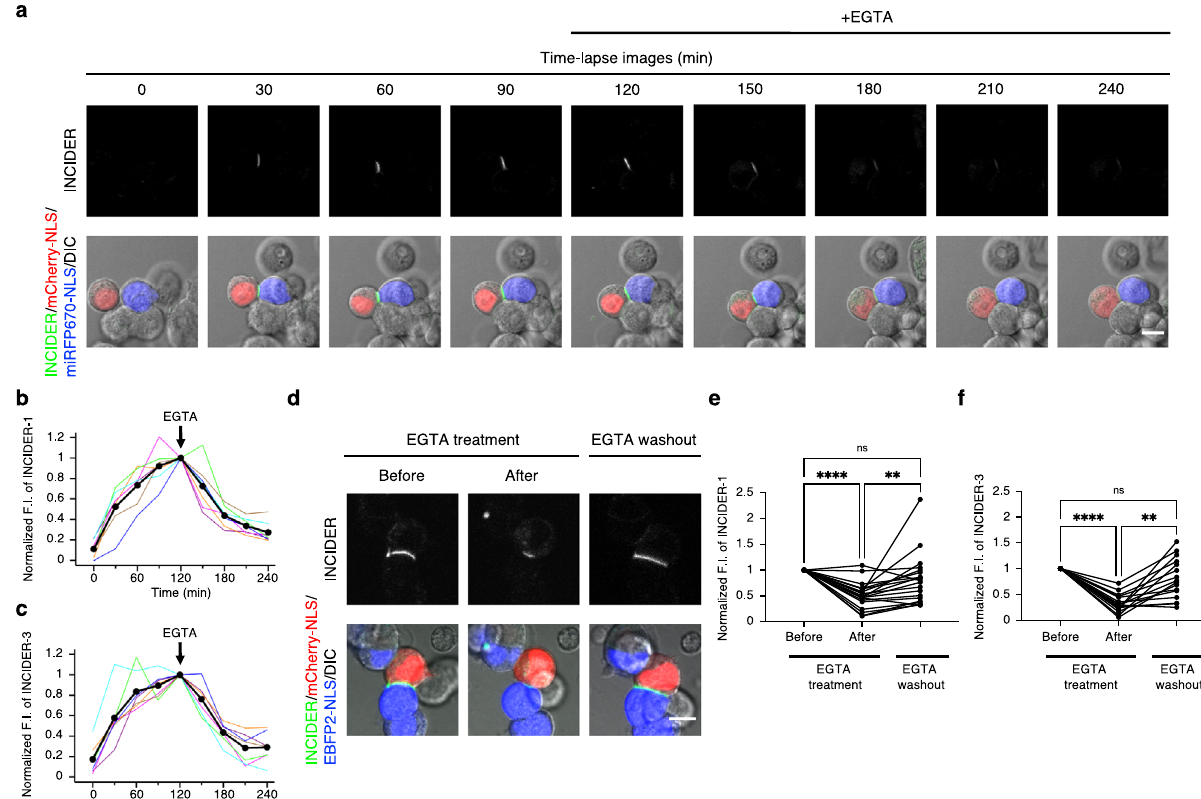
Fig. 4 Monitoring of the dynamics of NCad interactions. a Time-lapse images of INCIDER-1. HEK293T cells individually expressing INCIDER-1 components (NCad-GA and NCad-B1) were observed for 120 min immediately after seeding. 10 mM EGTA was administrated 120 min after seeding, and cells were imaged for a further 120 min. NCad-GA and NCad-B1 expressing cells were marked by mCherry-NLS and miRFP670-NLS, respectively. Scale bar, 10 μ m. b , c The normalized fl uorescence intensities at the cell adhesion sites formed by INCIDER-1 ( b ) and INCIDER-3 ( c ) were plotted over time. Values were normalized by the fl uorescence intensity of INCIDER at 120 min. Colored lines represent the fl uorescence changes from individual cell adhesion sites, and black circles indicate the averaged time course. 7 cell adhesion sites (both INCIDER-1 and INCIDER-3) from seven (INCIDER-1) and six (INCIDER-3) independent experiments were analyzed. Signi fi cant differences at each time point between INCIDER-1 and INCIDER-3 were not con fi rmed by a Mann – Whitney U test ( p > 0.5 in all time points). d The effect of EGTA treatment and washout on the fl uorescence intensity of INCIDER-1. HEK293T cells individually expressing INCIDER-1 components (NCad-GA and NCad-B1) were observed at 1 h after seeding. After 2 h from 10 mM EGTA treatment, cells were washed to remove EGTA and further cultured for 3 h under a microscope. Scale bar, 10 μ m. e , f Changes in fl uorescence intensities of INCIDER-1 ( e ) and INCIDER-3 ( f ) at the cell adhesion sites were quanti fi ed. Values were normalized by the fl uorescence intensity of INCIDER before EGTA treatment. Signi fi cant differences were analyzed by Friedman test, followed by Dunn ’ s multiple comparison test. **** p < 0.0001, ** p < 0.01, ns indicates p > 0.05. 20 (INCIDER-1) and 16 (INCIDER-3) cell adhesion sites from eight (INCIDER-1) and ten (INCIDER-3) independent experiments were